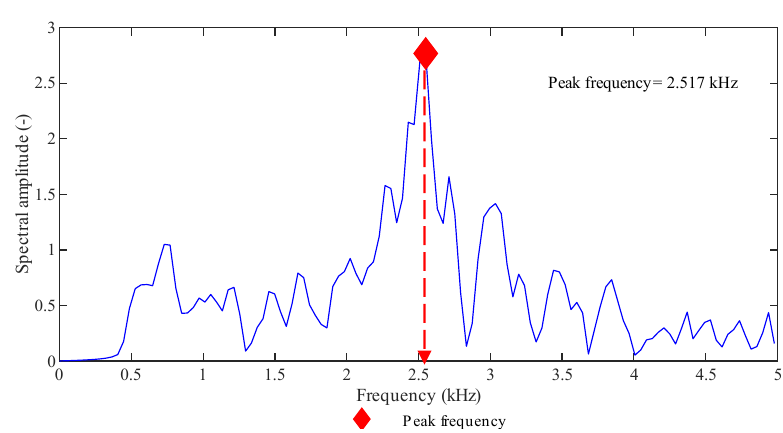
Figure 3. AE signal and parameters expressed in the frequency-domain.